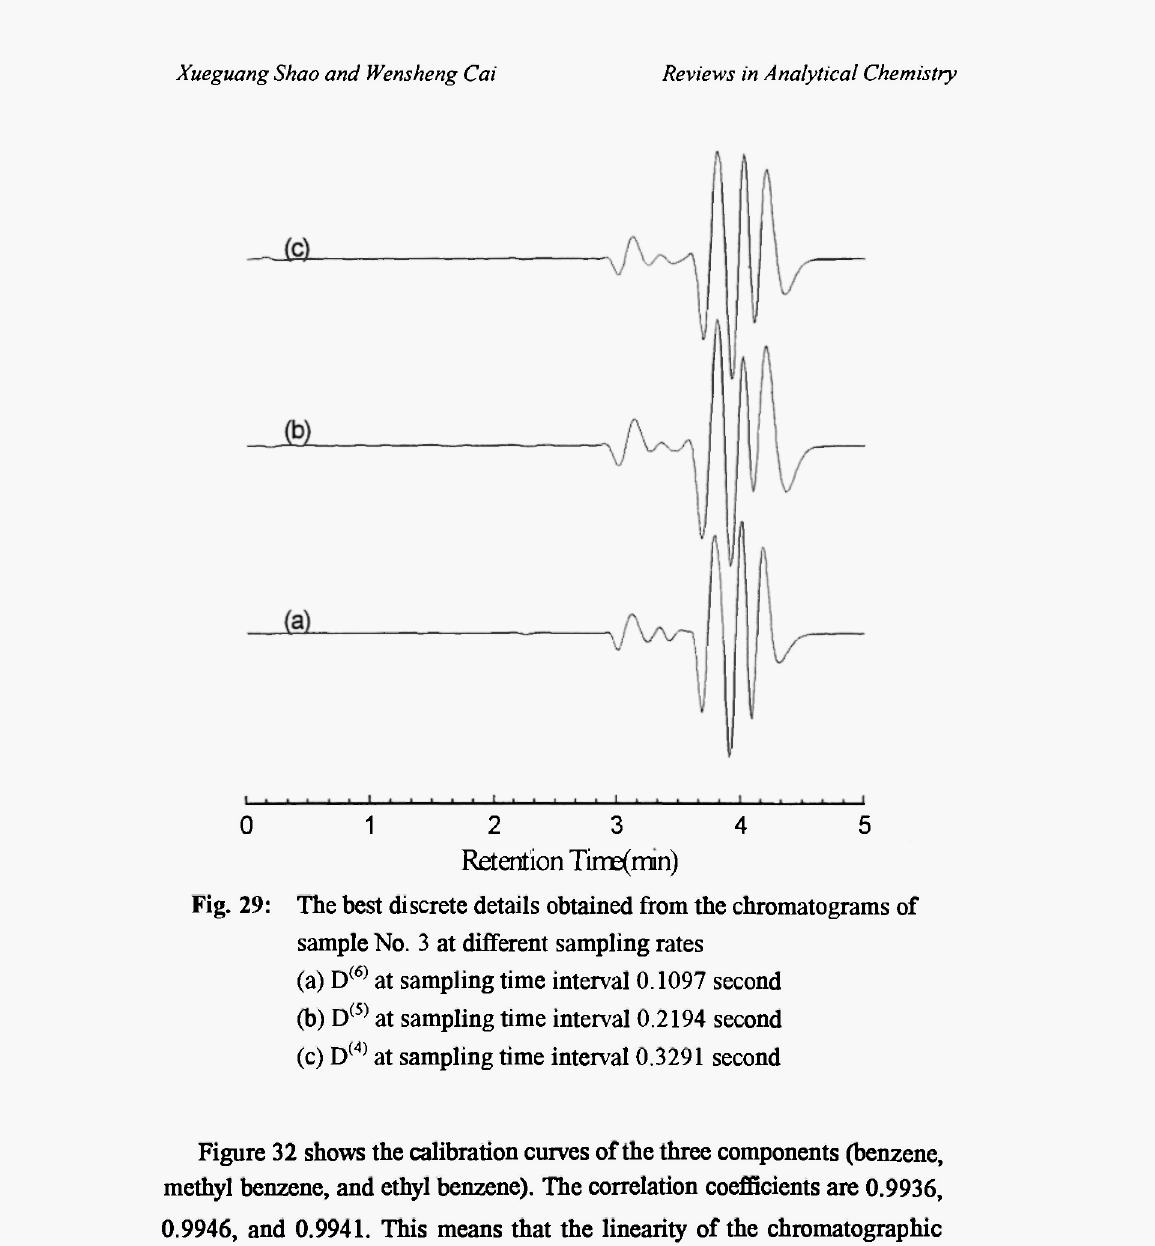
Fig. 29: The best discrete details obtained from the chromatograms of sample No. 3 at different sampling